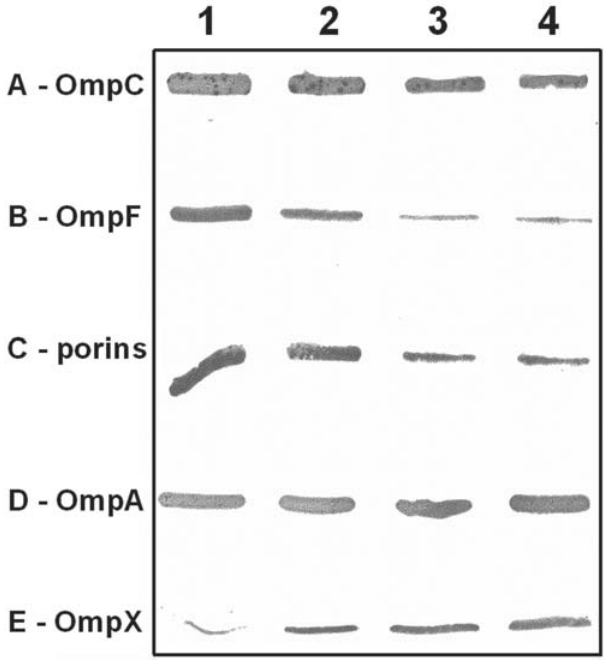
Figure 2. Immunodetection of the outer membrane proteins. The detections were carried out using antisera prepared against OmpC porin (A), OmpF porin (B), antigenic peptide located inside the internal loop 3 porin (C), OmpA (D) and OmpX (E) respectively. Immunodetec- tion were carried out with total cell extracts from non-induced AG100 (1, 2) and 10 mg/mL TET-induced (3, 4) strains grown in LB and MH media (odd and even lanes respectively).